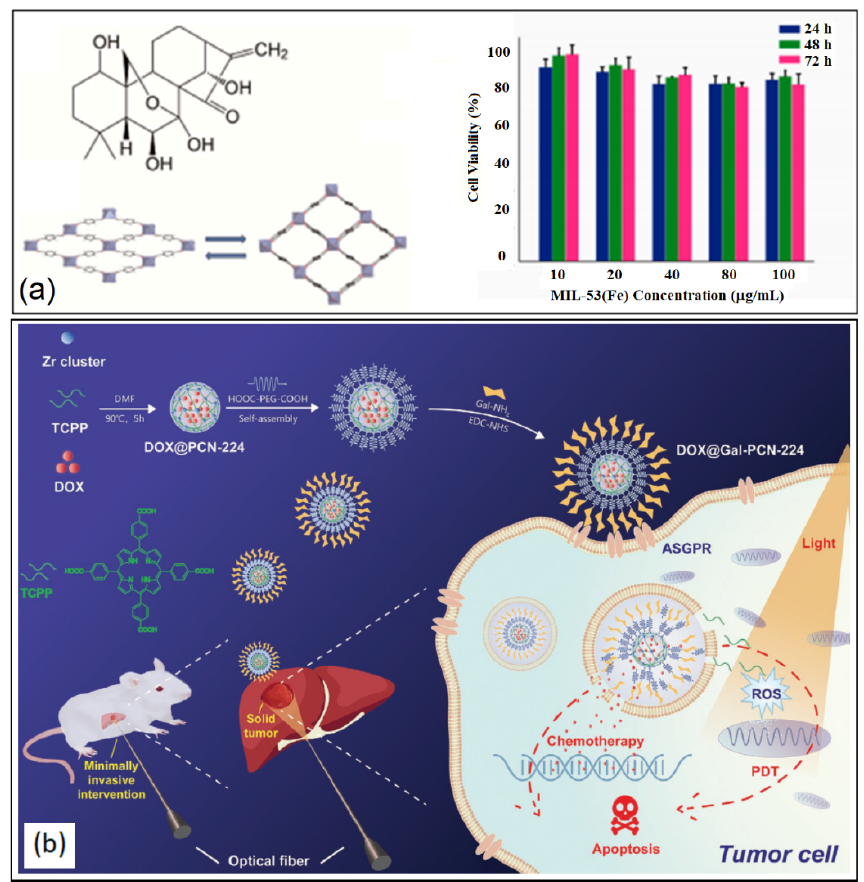
Figure 15. Applications of chemically modified BioMOF nanostructures for Hepatic Cancer Treatment. ( a ) MIL-53(Fe). Reproduced with permission from Ref. [59]. Copyright © 2018, MDPI. ( b ) DOX@Gal- PCN-224. Reproduced with permission from Ref. [65]. Copyright © 2020,